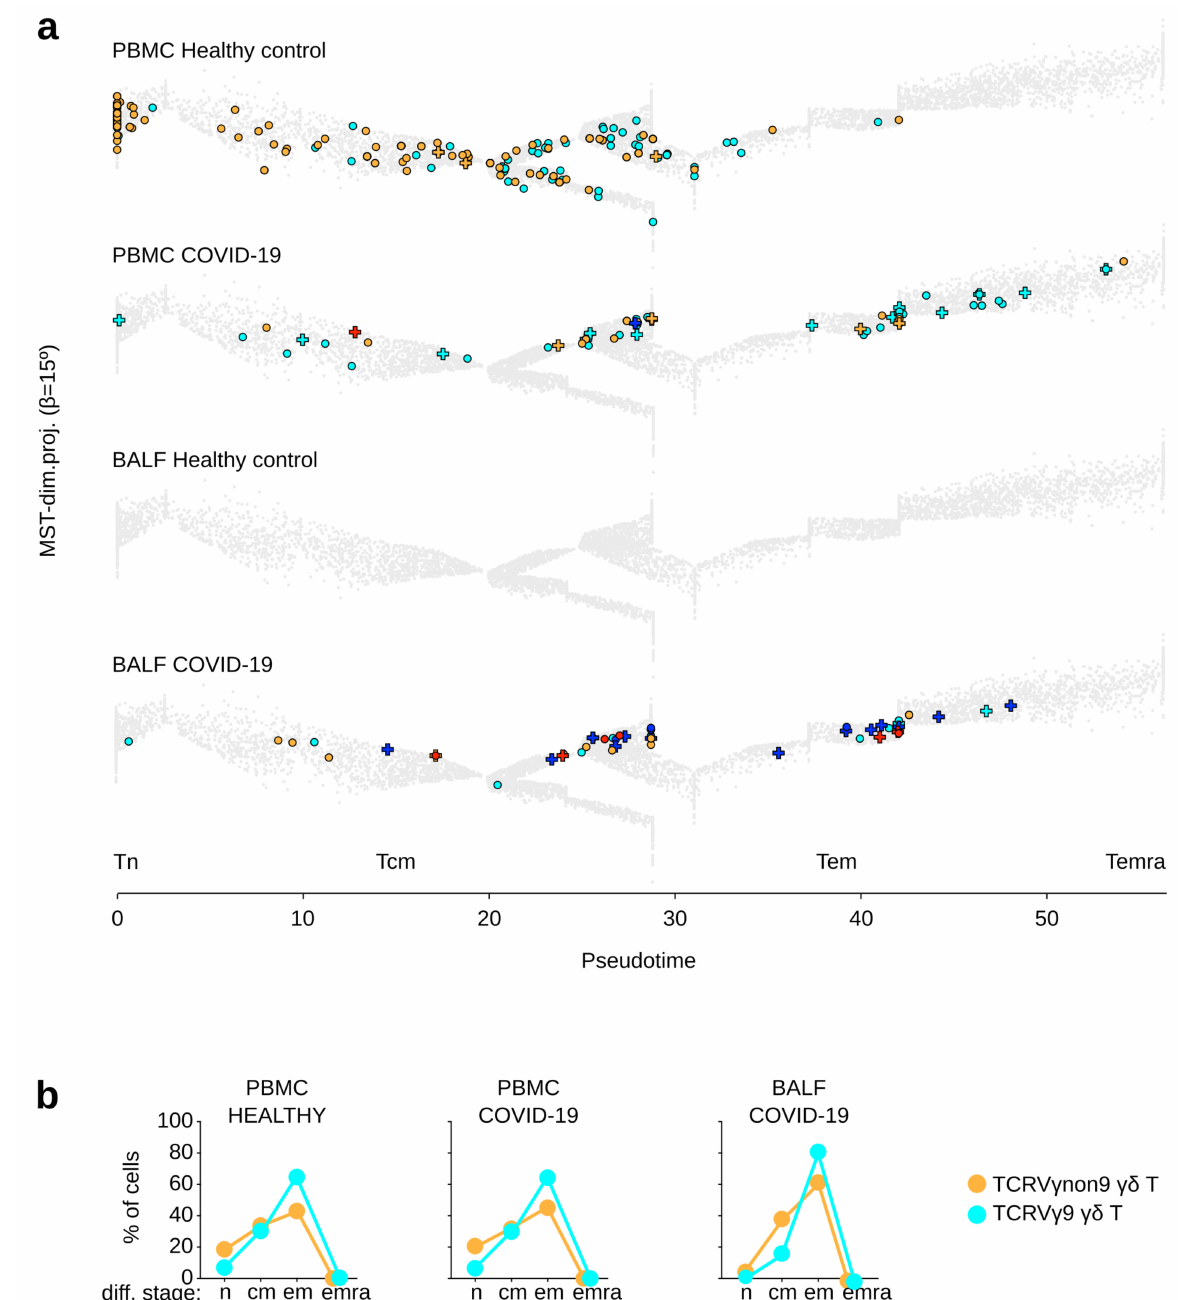
Figure 2. Differentiation and functional hallmarks of γδ T lymphocytes from control donor’s PBMC and BALF. ( a ) γδ T lymphocytes extracted from PBMC and BALF of healthy individuals and COVID-19 patients. No γδ T lymphocyte was found in any of the healthy control’s BALF (representative examples, cells are shown overlaid on the public trajectory of γδ T lymphocyte differentiation, same legend key as in Figure 1). ( b ) Rates of cells at each differentiation stage among the TCRV γ 9 and TCRV γ non9 γδ T lymphocytes (group means are shown). These data suggest that in adult COVID-19 patients, both subsets of γδ T lymphocytes relocalize from PBMC to the infected lung tissue, where their advanced differentiation, tissue residency, and exhaustion hallmarks witness of a recent T cell